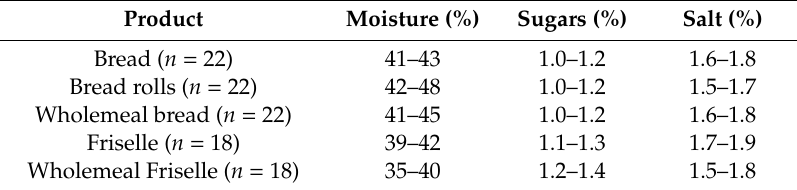
Table 2. Moisture, sugar, and salt percentage in each product of bread category.